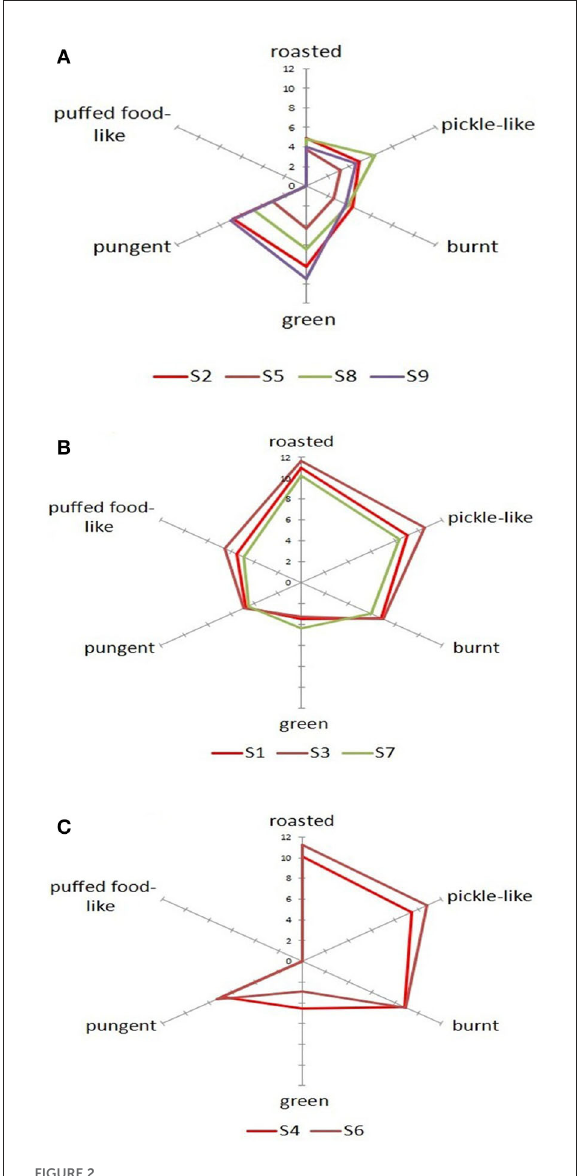
FIGURE2 Distribution diagrams of the sensory characteristics of the nine fragrant rapeseed oils. (A) Delicate fragrance. (B) Umami fragrance. (C) Strong